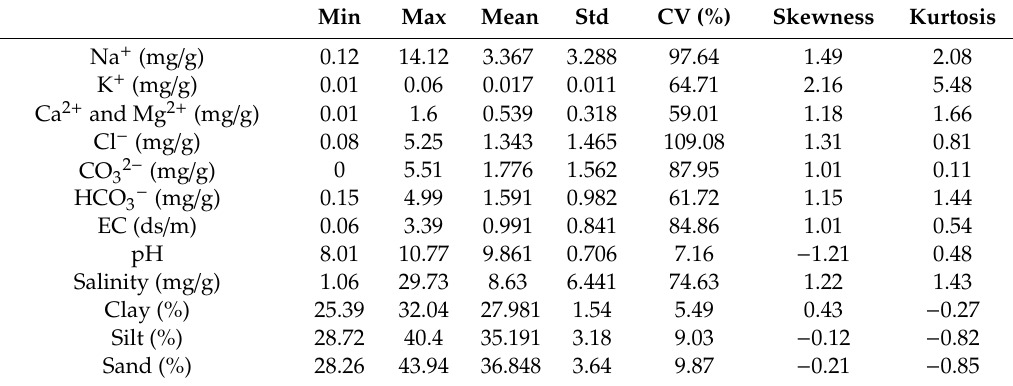
Table 1. Statistical description of the characteristics of the soil properties of the soil samples.